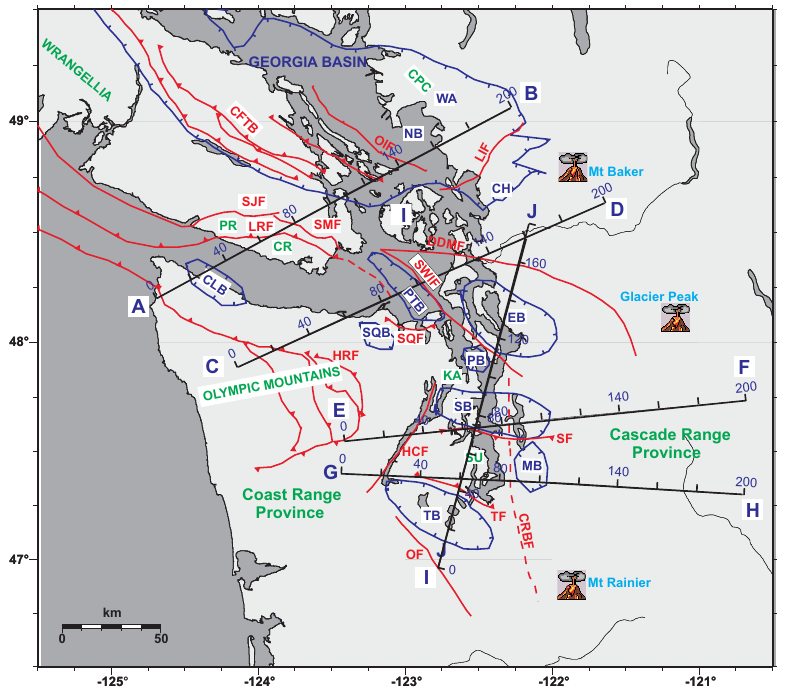
Figure 1 Fig. 1. Location map showing the study area. Vertical cross-sections of velocities and spatial gradients of velocities along profiles